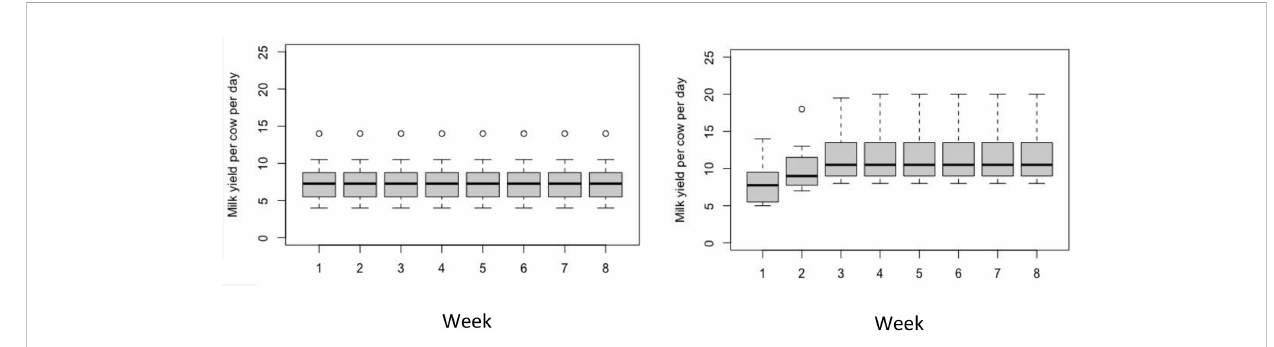
FIGURE 5 Comparison of effects of traditional feeding practice (left) and intervention diets (right) on milk income (Birr/day).